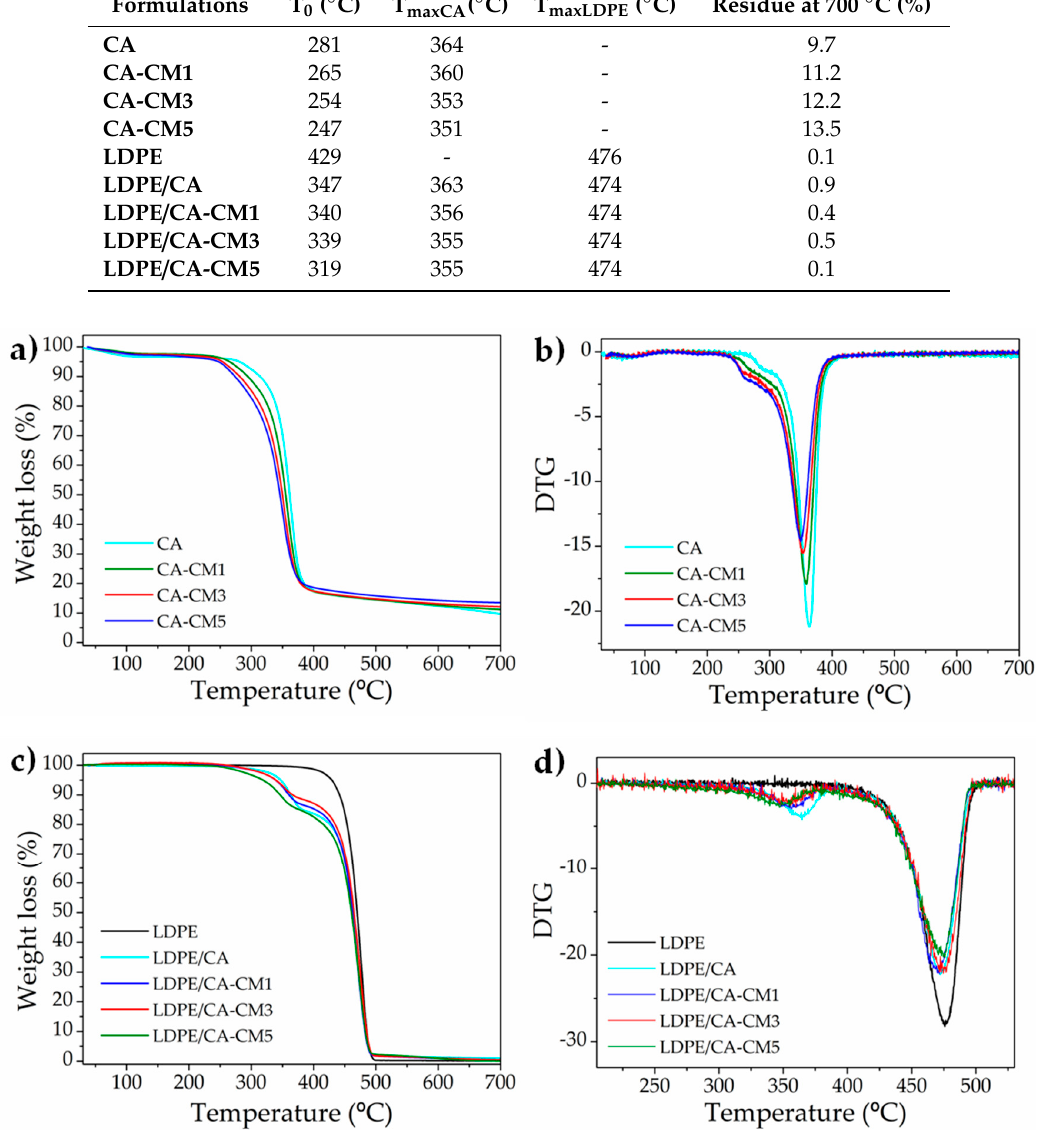
Figure 5. Thermogravimetric analysis: ( a ) TGA of CA-based layer, ( b ) DTG of CA-based layer, ( c ) TGA of LDPE/CA-based bilayer, and ( d ) DTG of LDPE/CA-based bilayer.